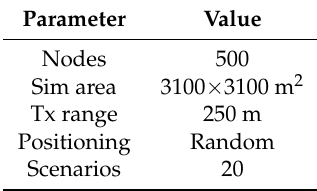
Table 5. Simulation